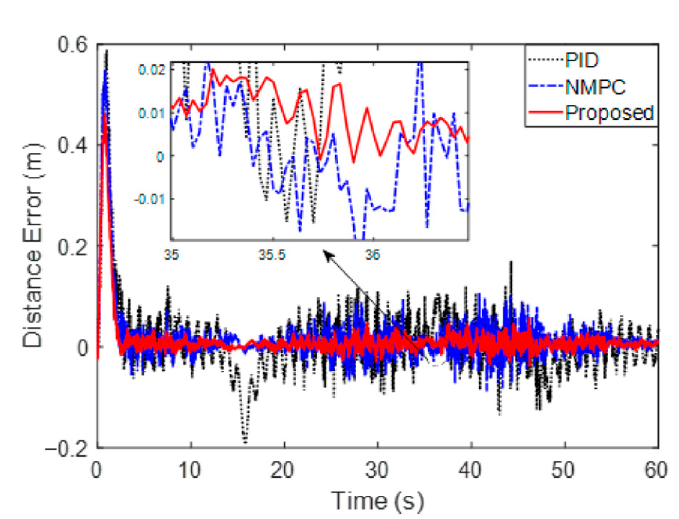
Figure 6. Distance error of the comparison method.